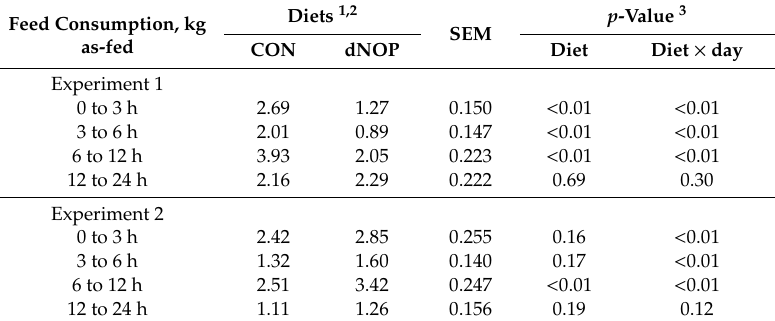
Table 4. Feed consumption rates and preference of beef steers ( n = 9) for a high forage (Exp. 1) or grain diet (Exp. 2) supplemented with or without 3-NOP ( n =